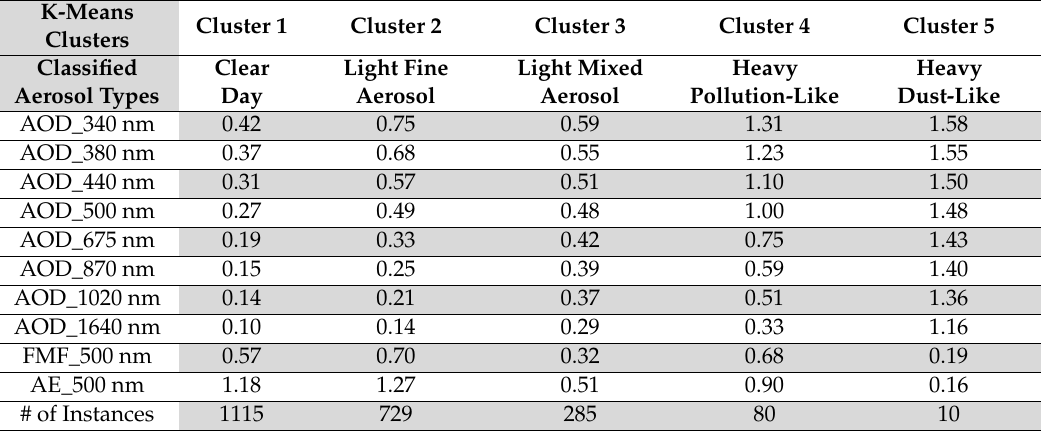
Table 2. AERONET AOD bands, fine mode fraction (FMF), Ångström exponent (AE), and number of instances values for five